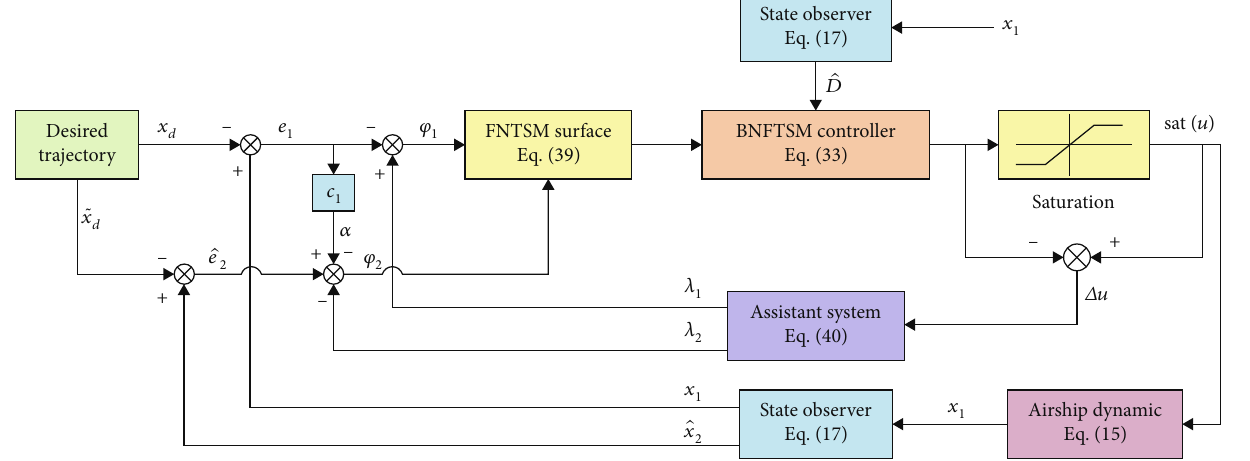
Figure 2: Block diagram of the robust fi nite-time